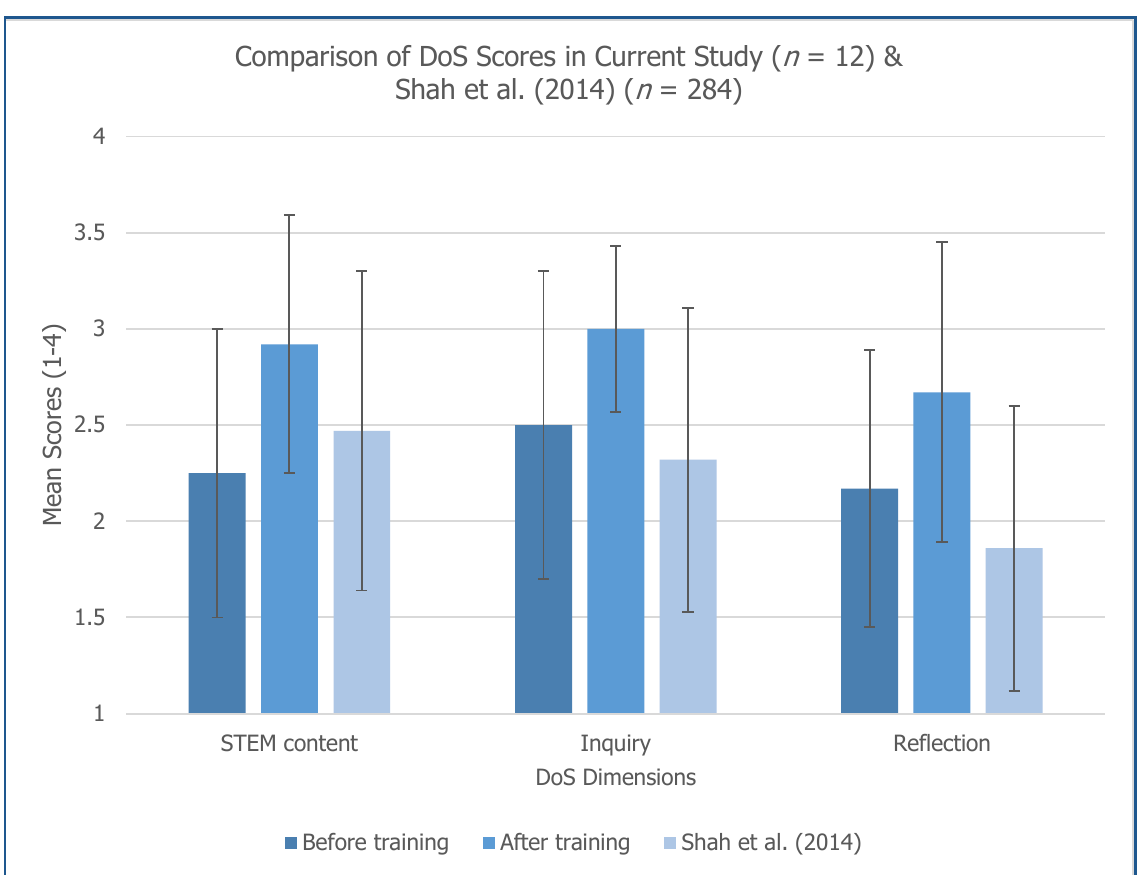
Figure 3. Average DoS Rating in Current Study and From Shah et al.